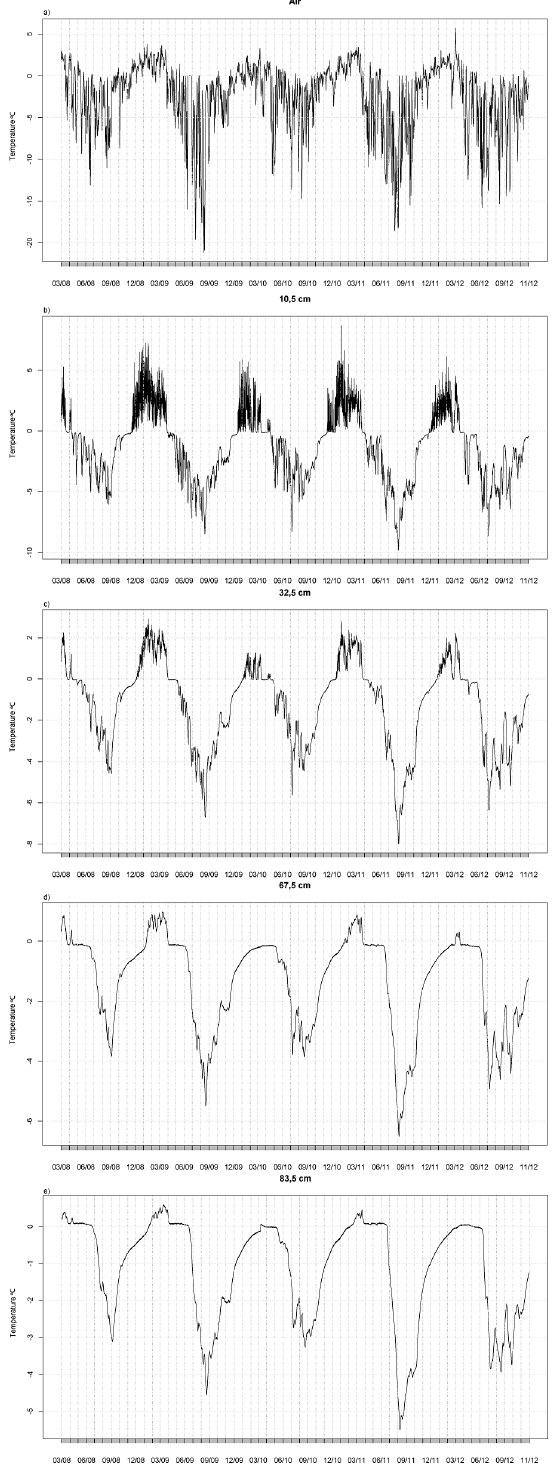
Figure 2. Daily temperatures records for air (a) , F1 (b) , F2 (c) , F3 (d) and F4 (e)